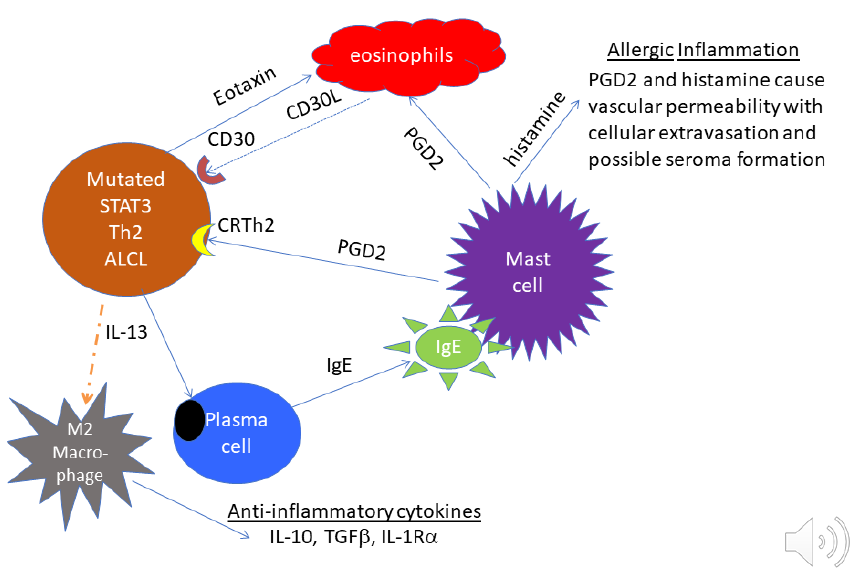
Figure 3. Proposed relationship between tumor cells and microenvironment in BIA-ALCL. On the left, tumor cells with mutated STAT3 release Eotaxin which attracts eosinophils. Eosinophils are known to express the CD30 ligand, which can support the proliferation of CD30+ tumor cells. At the lower left, tumor cells release IL-13 that polarizes macrophages to produce anti-inflammatory cytokines and induces plasma cells to produce IgE. In the center and upper right, IgE activates mast cells to release PGD2 to attract Th2 cells and eosinophils. PGD2 and histamine from activated mast cells cause vascular permeability, which may contribute to seroma